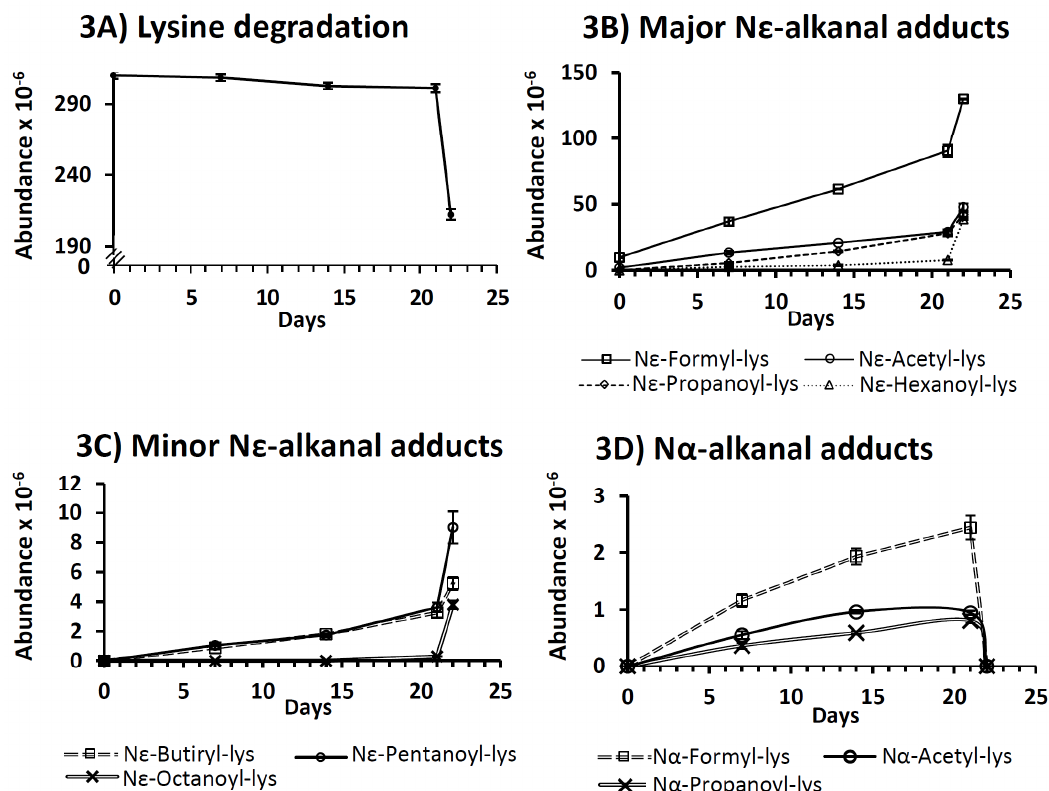
Figure 3. Evolution of the abundances in the aqueous extracts of the RSO + 2LYS oil sample obtained throughout the oxidation process, determined by LC–MS, of the base peaks of: ( A ) lysine; ( B ) major N ε -lysine-alkanal adducts; ( C ) minor N ε -lysine-alkanal adducts; and ( D ) N α -lysine-alkanal adducts. All the figures reported are mean values. Lys: lysine.